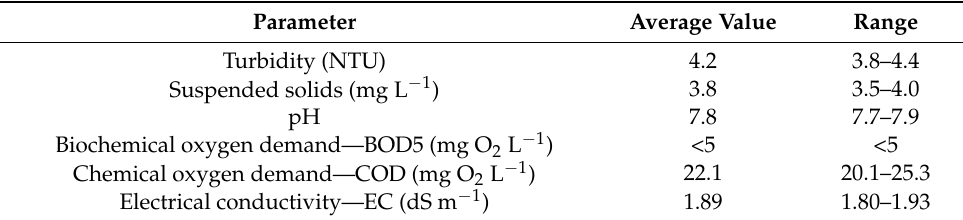
Table 1. Physical and chemical parameters of reclaimed water. Seven samples analyzed during the irrigation